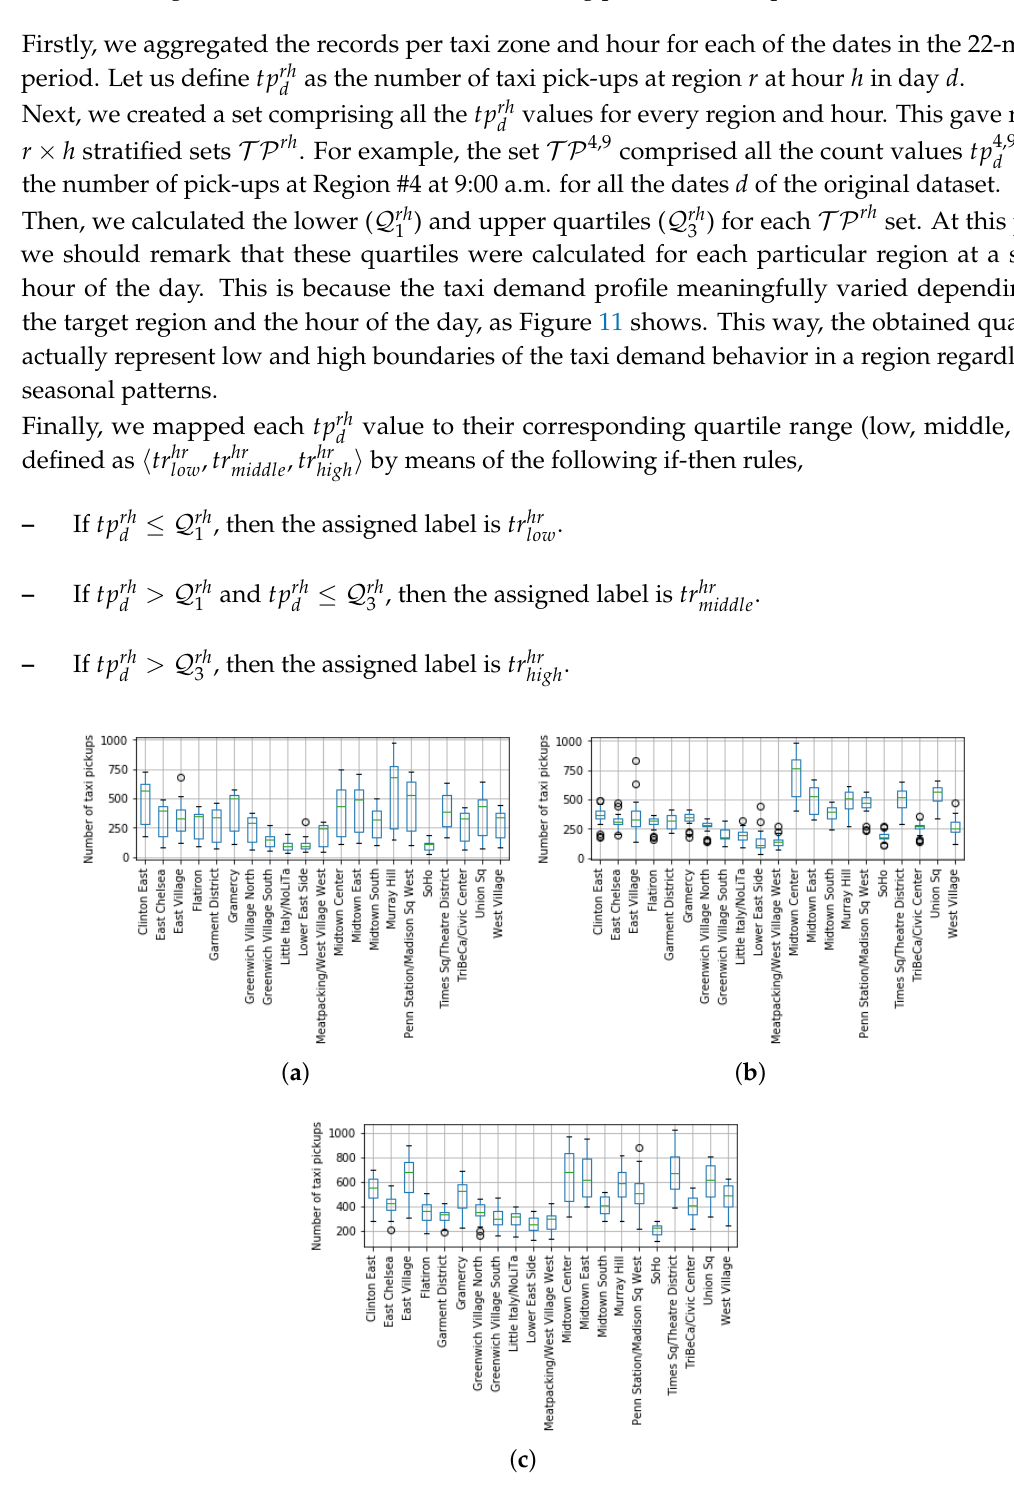
Figure 11. Boxplots of the pick-ups per taxi zone at three particular hours of the day. The top side of each box represents the upper quantile Q rh of a region, whereas the bottom side stands for the lower 3 one Q rh . ( a ) 8:00; ( b ) 15:00; ( c ) 1